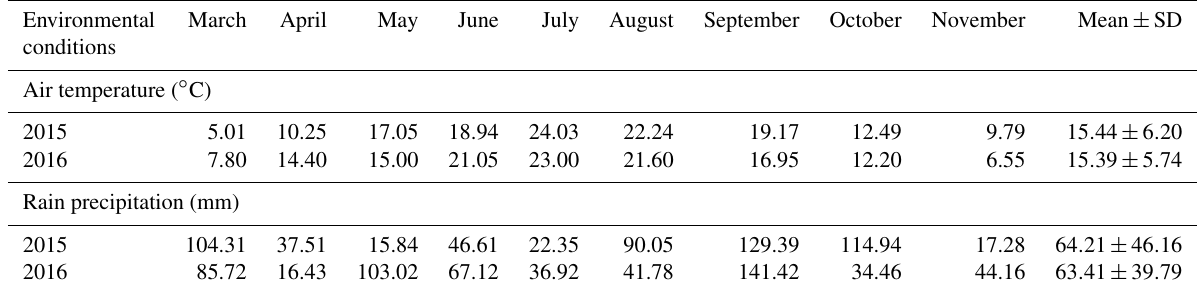
Table 1. Mean annual and monthly values of rain precipitation (mm) and air temperature ( ◦ C) during the experimental period.